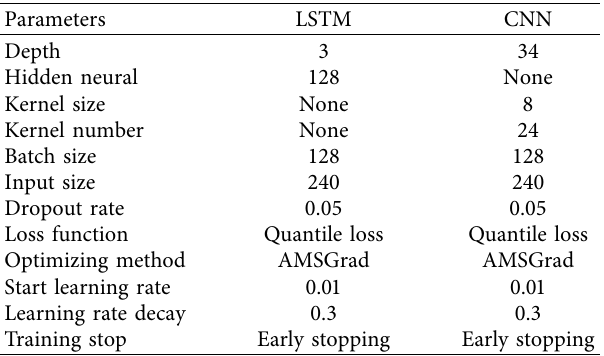
Table 1: Shared parameters of neural networks and related strategies